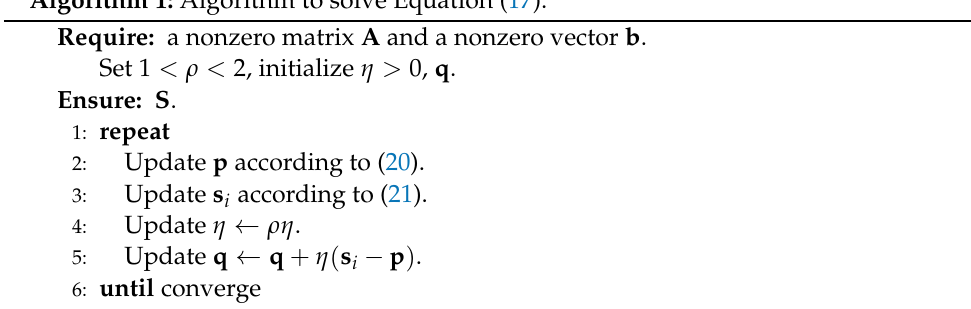
Algorithm 1: Algorithm to solve Equation